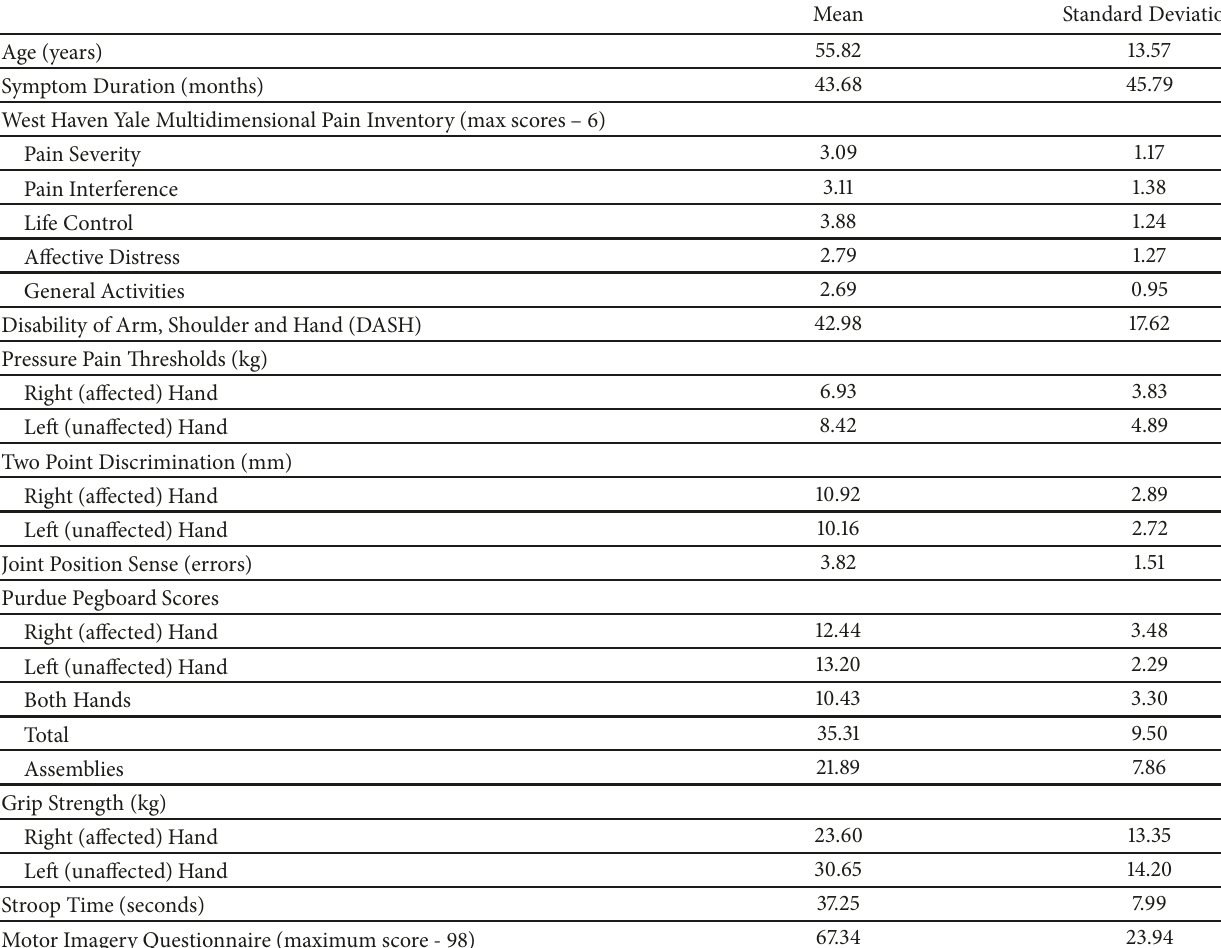
Table 1: Participant descriptive